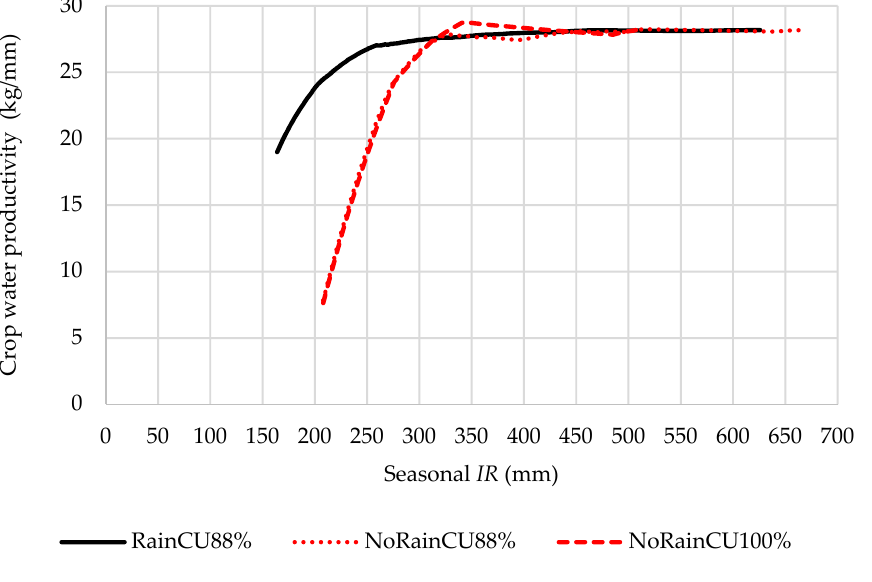
Figure 9. Crop water productivity as a function of applied irrigation water ( IR ) for a uniform (CU100%) and non-uniform (CU88%) application in the presence rainfall (Rain) and no rainfall (NoRain).